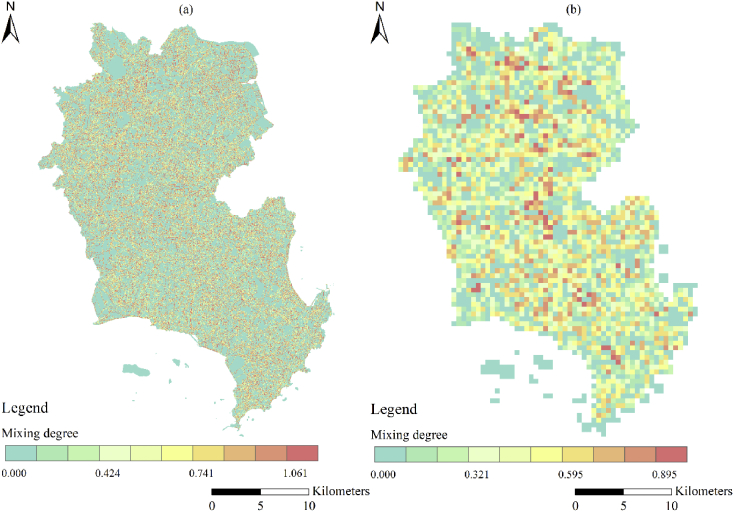
The mixing degree of urban functional district (UFD). (a) and (b) represent the mixing degree of UFD at R30m and R500m respectively.